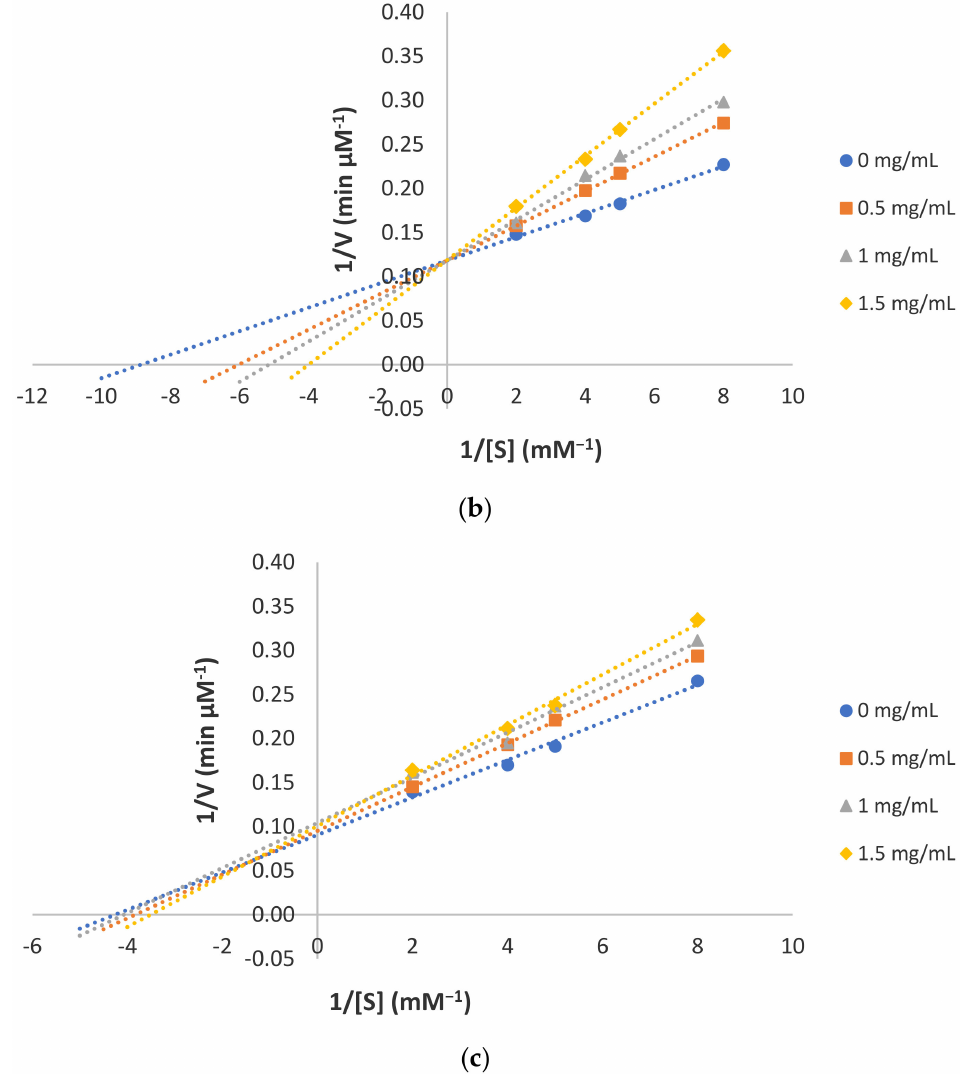
Figure 1. Lineweaver–Burk plot for the inhibition of monophenolase activity by ( a ) MIP1; ( b ) MIP2; and ( c )